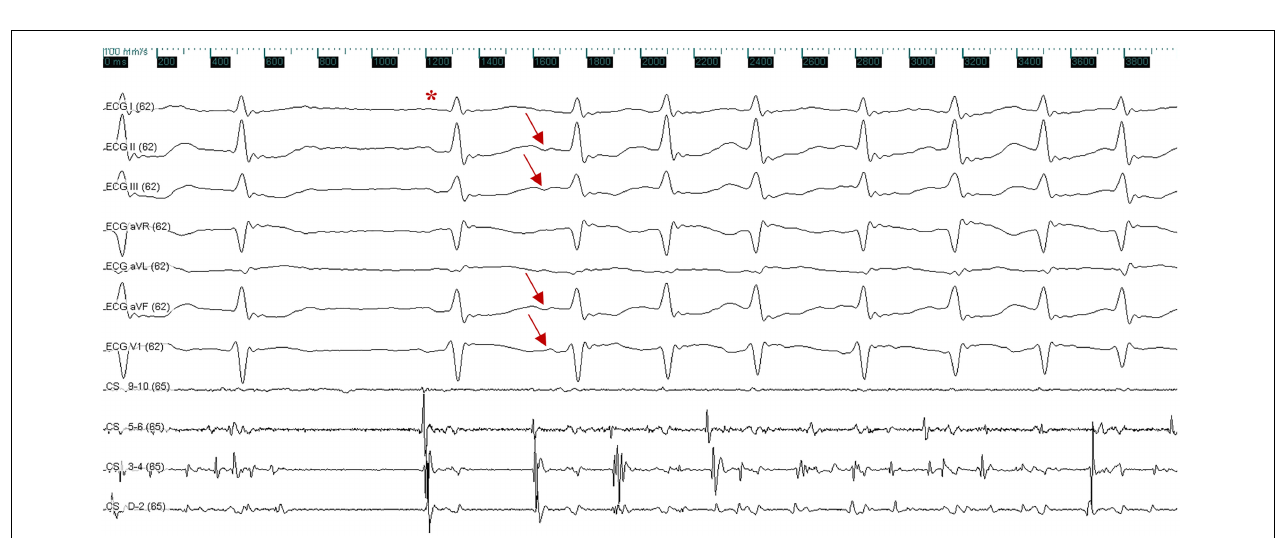
FIGURE 1 | Electrocardiogram showing atrial flutter with atrial rate 280–290/min with variable atrioventricular conduction in the limb leads, the atrial wave displayed negative wave in inferior leads (II, III, and avF, black arrow). The precordial 6 lead rhythm strip shows termination of atrial flutter with a sinus beat (red asterisk), followed by four consecutive ectopic atrial beats at rate 250/min, which showed a narrow positive wave in lead V1 (red arrow). The first conducted beat occurred with the right brunch block, the second was blocked, the third conducted a with a narrow QRS, and the fourth was blocked. This followed by another sinus beat followed by the same atrial tachycardia/atrial flutter at a rate of 260/min. The ECG was recorded at a speed of 25 mm/s (x axis) and an amplitude of 10 mm/mV (y axis).